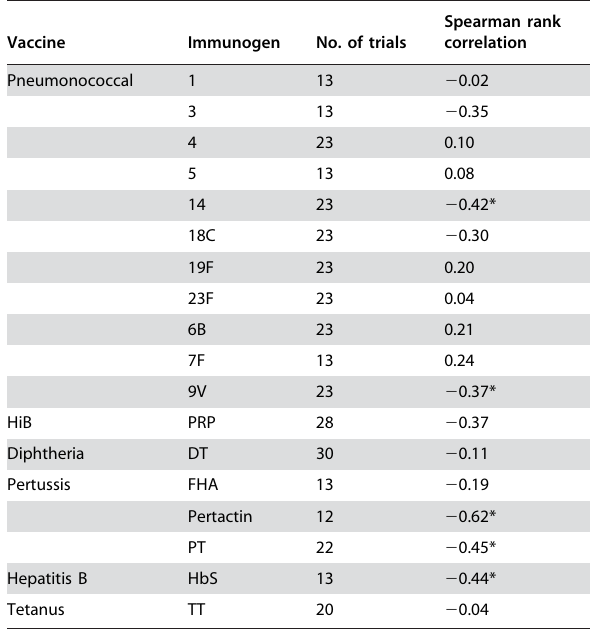
Table 1. Spearman rank correlation between geometric mean antibody responses and fold range of antibody responses in